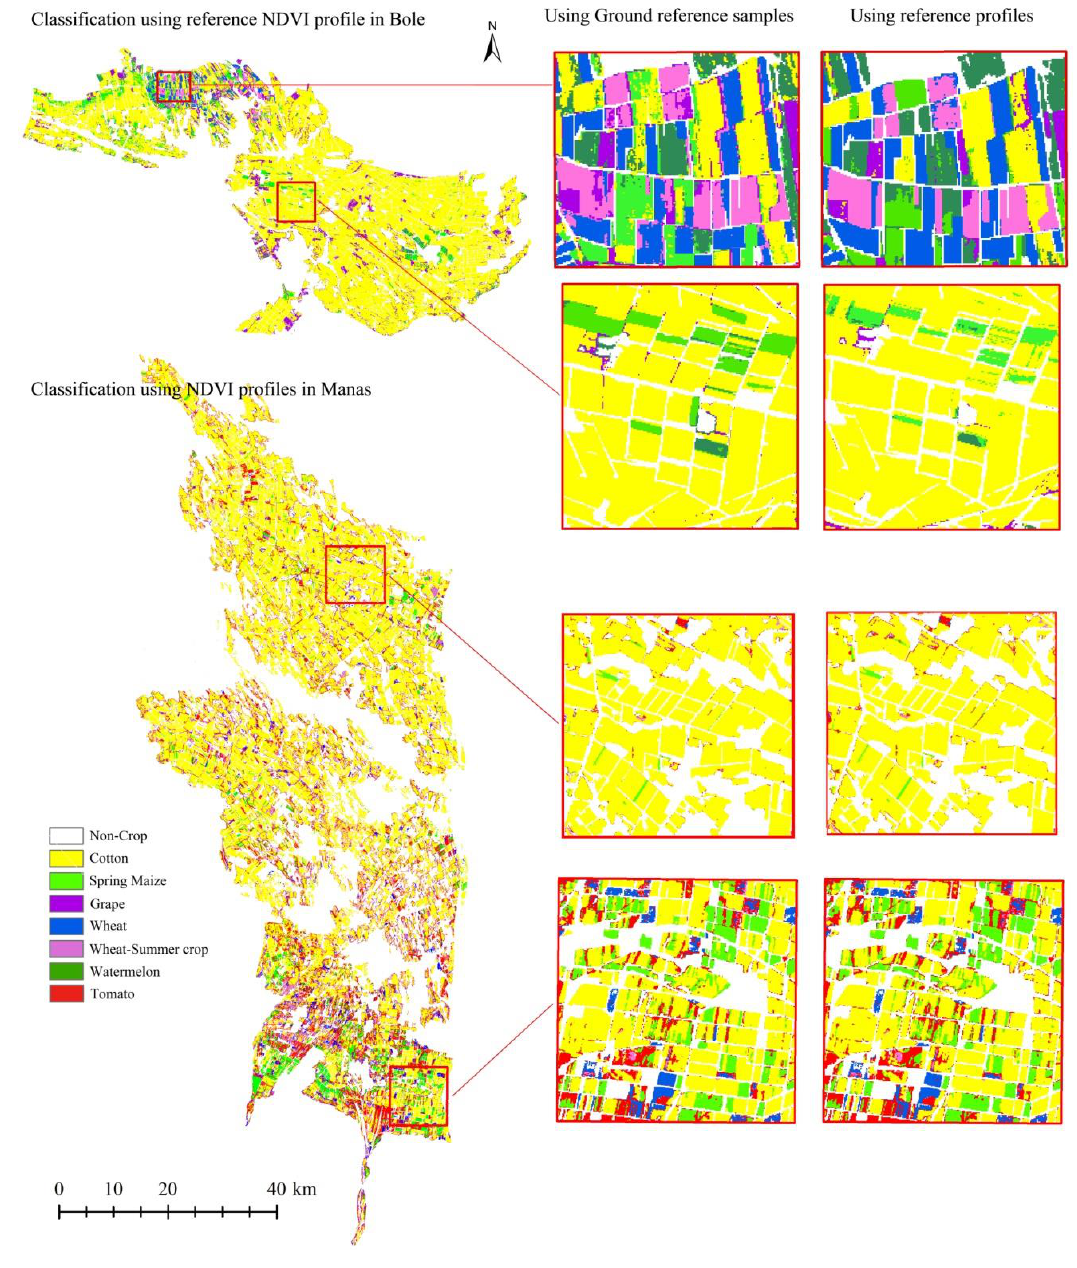
Figure 9. Crop map of Bole and Manas.